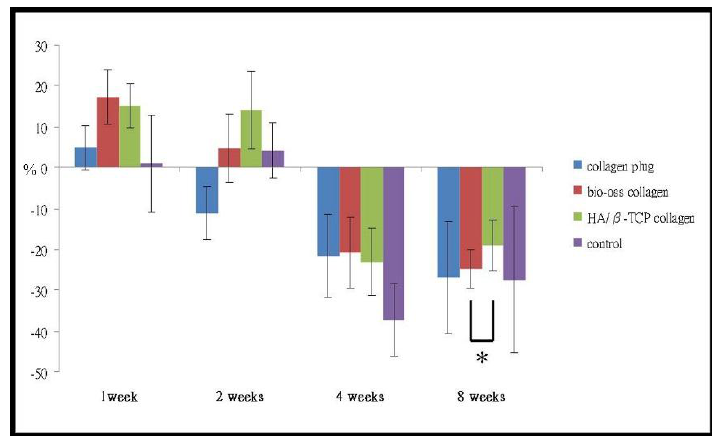
Figure 4. Horizontal dimensional change. Table 1. Horizontal dimensional changes after tooth extraction. Horizontal dimensional changes (in millimeters) of the alveolar bone implanted with collagen plugs, bovine graft-collagen composite,